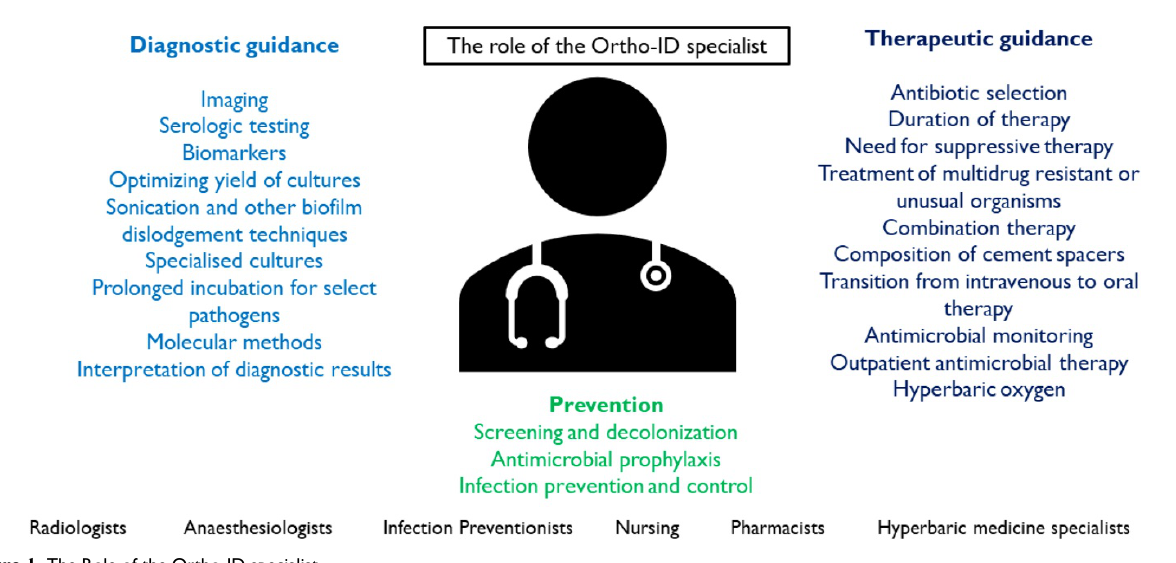
Figure 1. The Role of the Ortho-ID